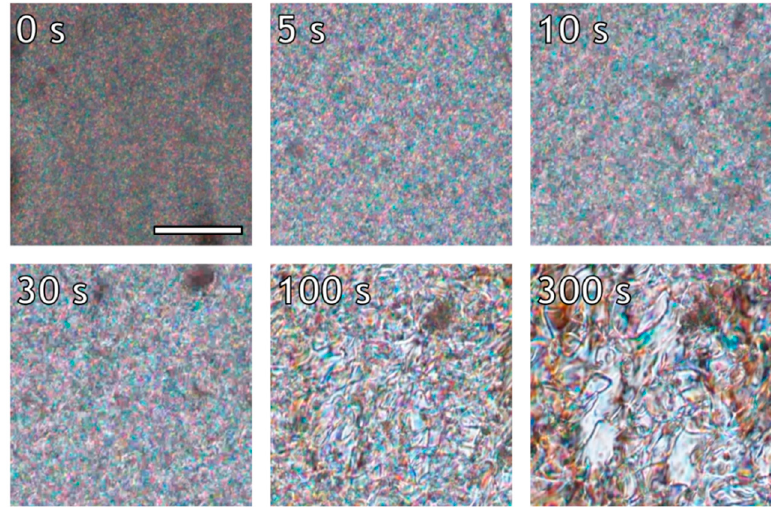
Figure 6. Relaxation from equilibrium texture of the LCP after the application of shear (16 s − 1 ) at 200 °C. Flow direction is vertical; the scale bar marks 100 µm, scale applies to all sub-images.